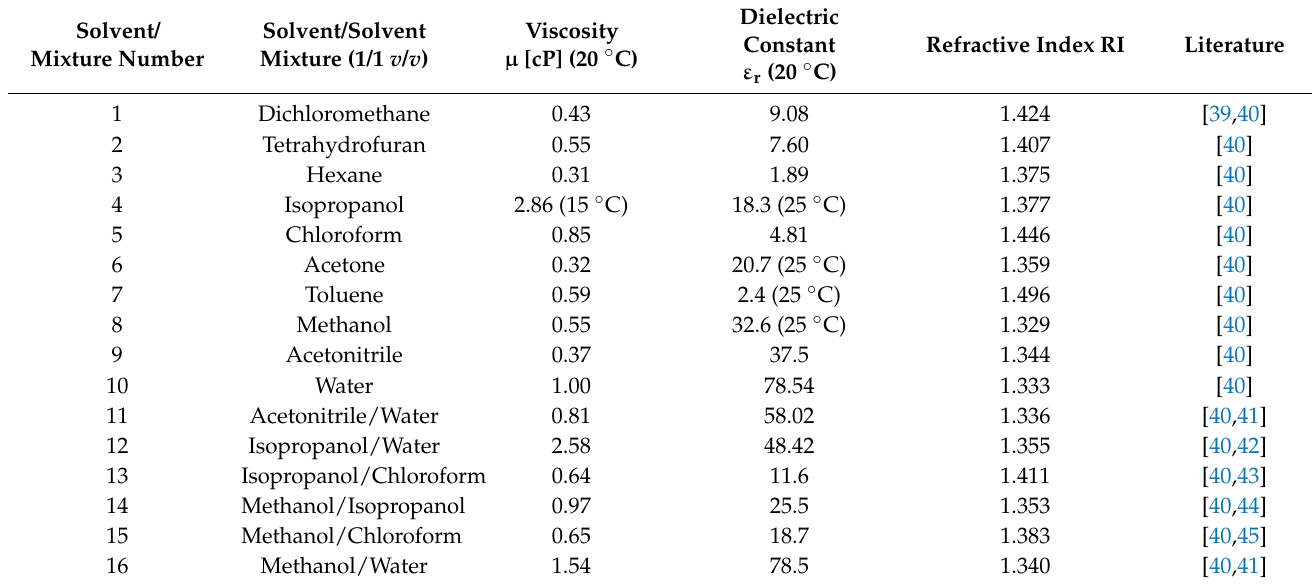
Table 1. Characteristic of solvents used in the study.